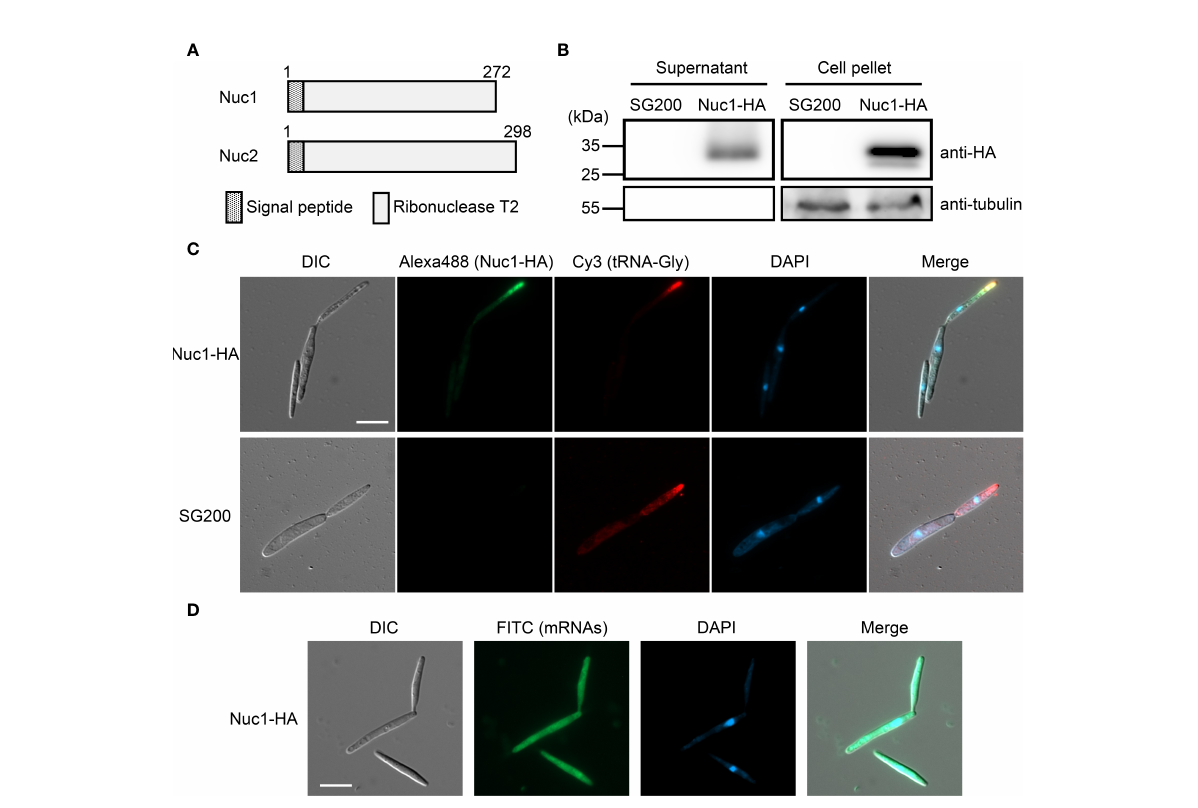
FIGURE 5 Cellular localization of Nuc1-HA protein in sporidia cells of U. maydis . (A) Schematic picture of Nuc1 and Nuc2 protein structures. Both proteins carry signal peptide at N-terminus. The entire protein sequence encodes ribonuclease T2 domain. (B) Western blot analysis of the strain expressing Nuc1-HA. Total proteins and secreted proteins from SG200 and SG200 D nuc1 - nuc1-HA were separated in 12% SDS-PAGE. Nuc1-HA protein was detected with anti-HA antibody and tubulin was detected with anti-tubulin antibody. (C) Immunocytochemistry and in situ hybridization for the detection of Nuc1-HA and tRNA-Gly in sporidia cells. Nuc1-HA localization was visualized by Alexa Fluor 488. tRNA-Gly localization was visualized by Cy3. Fungal nuclei were visualized by DAPI staining. Bar = 10 m m. (D) In situ hybridization for the detection of mRNAs in sporidia cells. mRNAs localization was visualized by FITC. Fungal nuclei were visualized by DAPI staining. Bar = 10 m